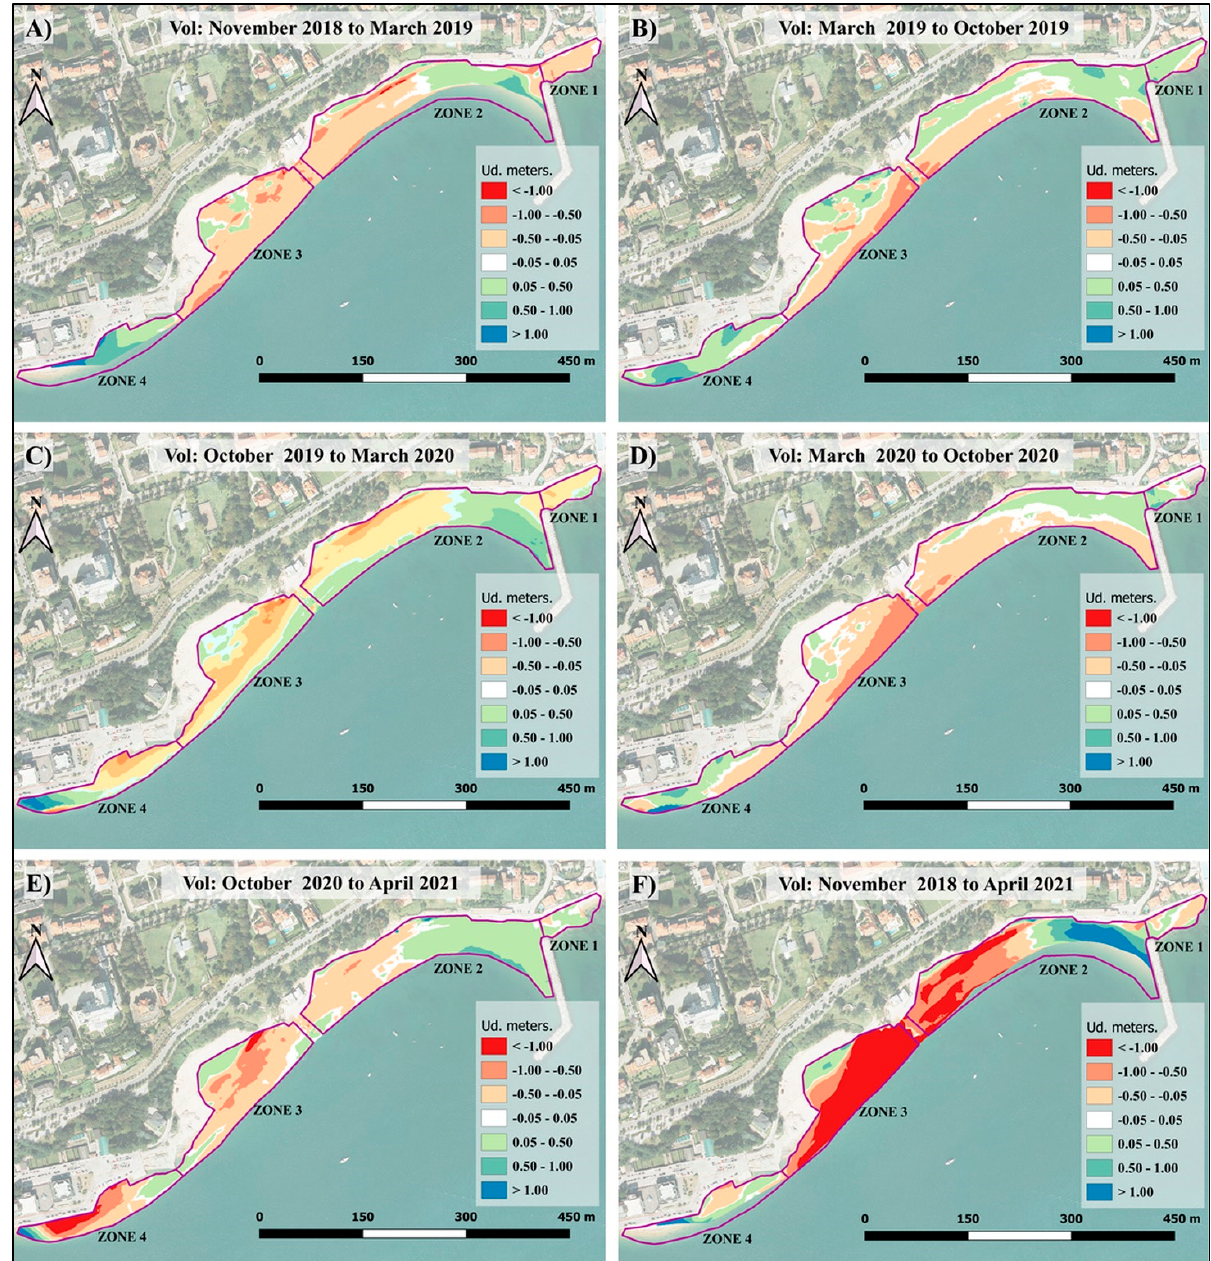
Figure 7. Comparison of beach sand surplus and deficit surfaces: ( A ) November 2018–March 2019.